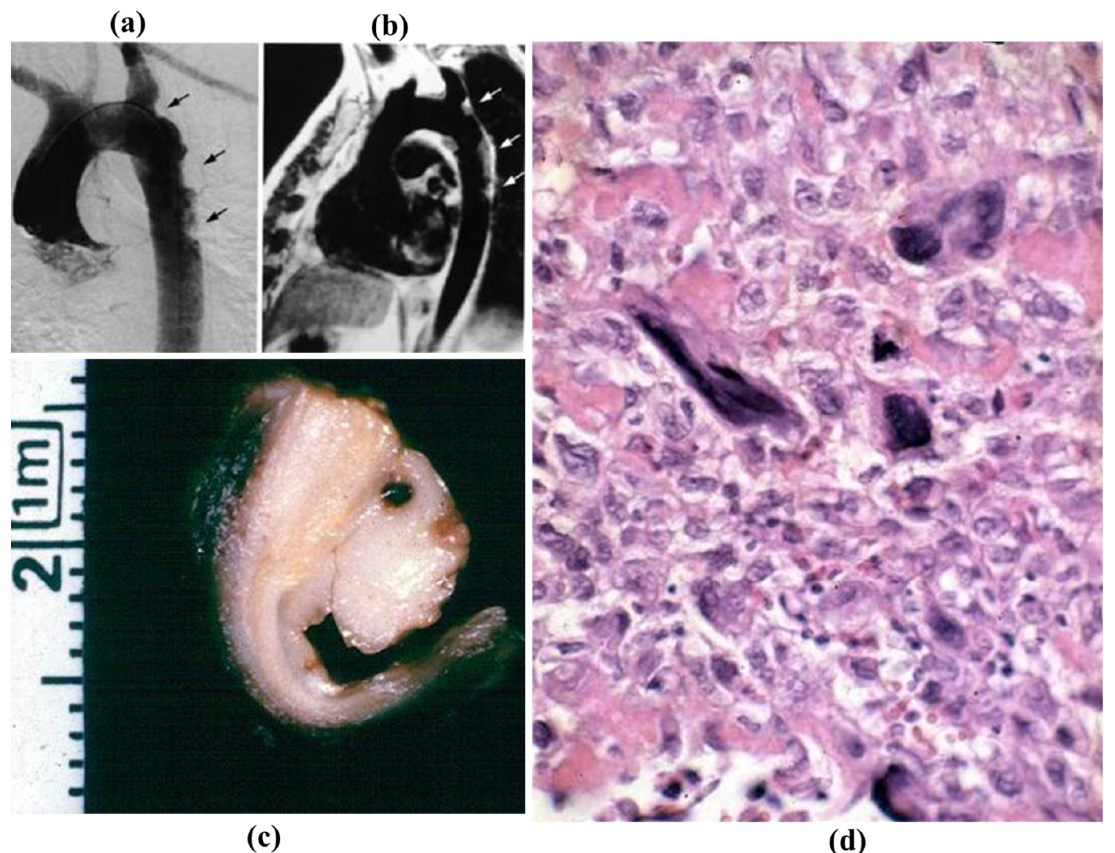
Figure 28. Intimal masses protruding into the lumen of the descending thoracic aorta at selective ( a ) and at tomography angiography ( b ). ( c ) Gross appearance of the specimens removed at surgery. ( d ) Malignant histiocytoma at histology (he- matoxylin-eosin).